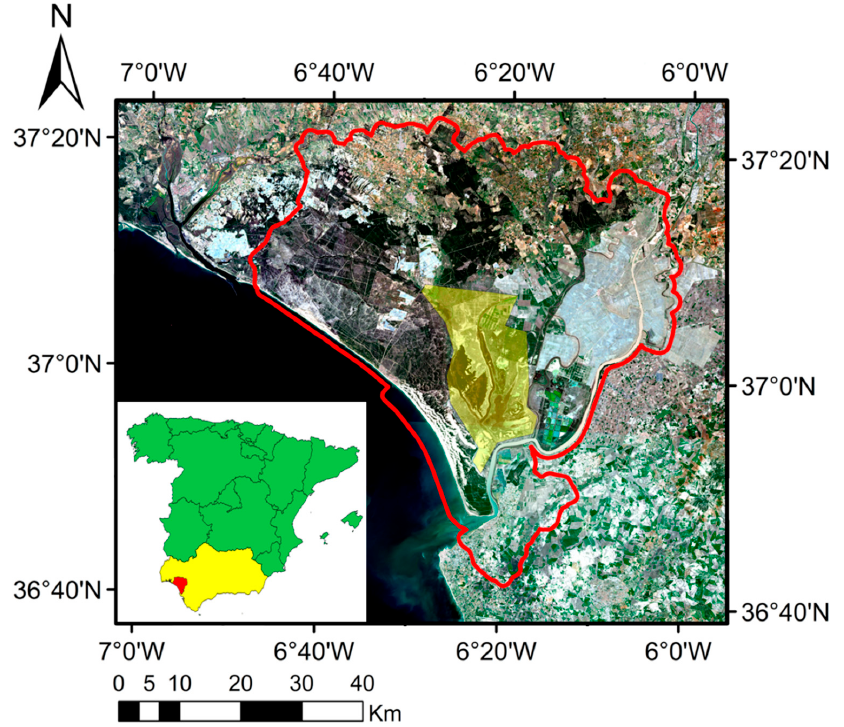
Figure 2. Map of the Doñana Biosphere Reserve located in Southwest Spain, falling within the Andalusia administrative region, with underlying S2 RGB image on 21 February 2018. Red line: boundary of the Biosphere Reserve. Yellow shaded area: Doñana marshland wetland area.